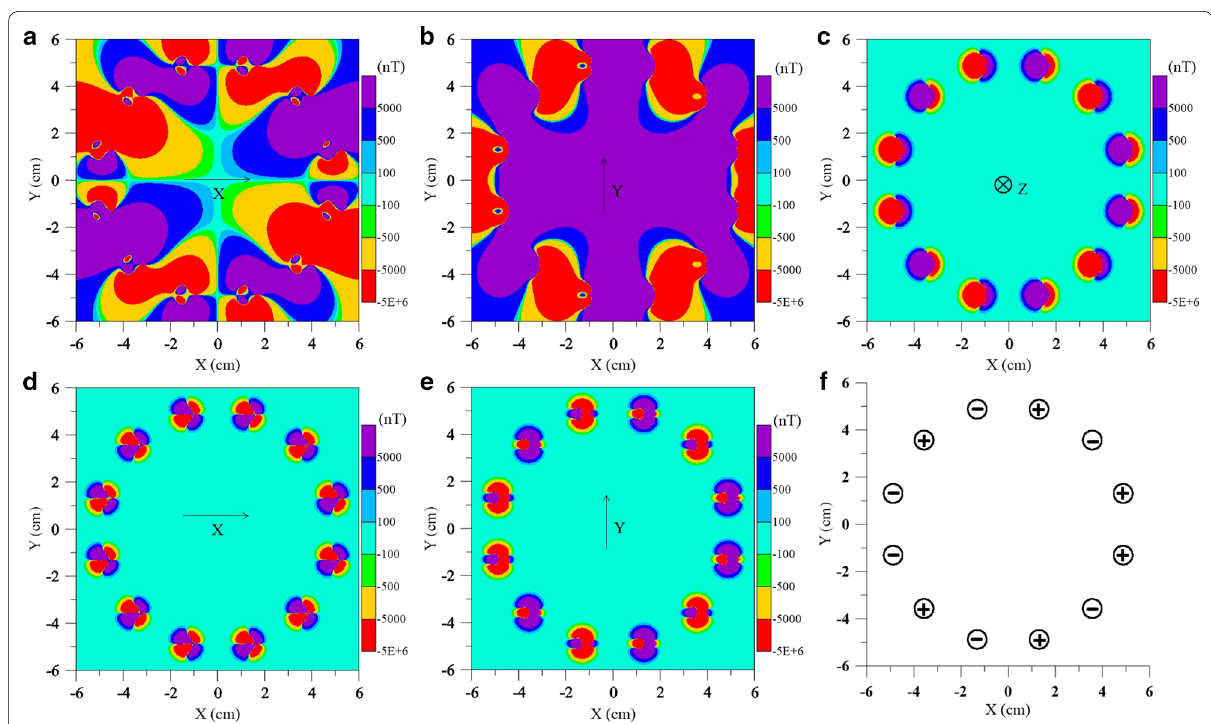
Fig. 5 Contour map of magnetic field distribution if the solenoids are wired such that the current flow is parallel. a – c The field distribution composed of 12 conventional solenoids, and d , e the field distribution with new heating elements. f The position of the solenoids and the corresponding current direction in adjacent. Letter X, Y, Z in the middle of the graph represents the direction of the magnetic